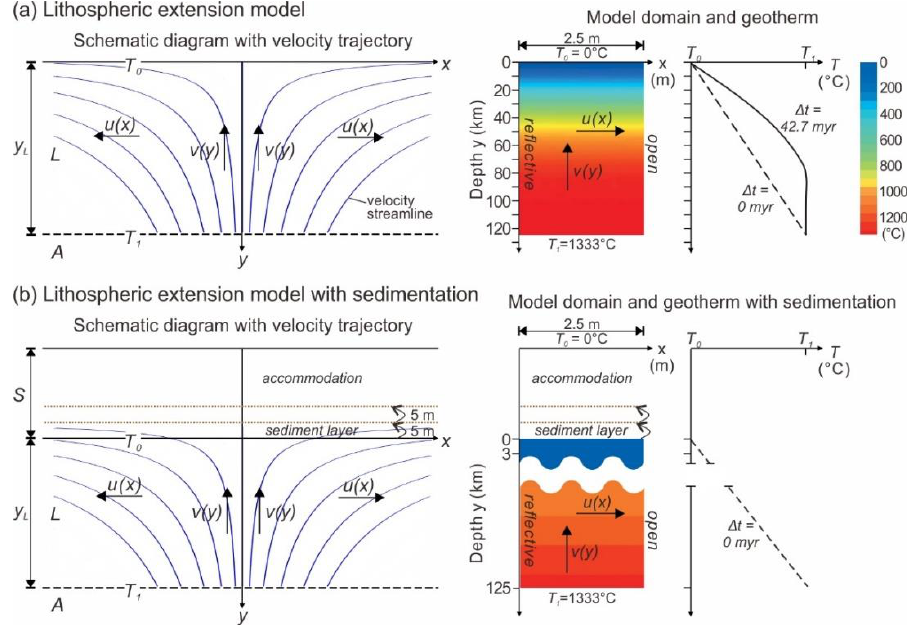
Figure 2. ( a ) Numerical lithospheric extension model (modified from [41]). A schematic diagram showing boundary conditions and velocity streamlines. Model domain and geothermal gradient of β = 2 and extension duration ∆ t = 42.7 myr. Steady-state temperature profile ( ∆ t = 0 myr) is shown (dashed line). ( b ) Numerical lithospheric extension model with successive stacking of 5 m thick sediment layers. A schematic diagram showing boundary condition, velocity streamlines, predefined accommodation, and sediment layers (dotted brown line). Model domain and geothermal gradient are shown with the steady-state temperature profile. L : lithosphere, A : asthenospheric mantle, S : predefined accommodation, T 0 : temperature of lithosphere top, T 1 : temperature of asthenospheric mantle, u ( x ) : horizontal velocity, v ( y ) : vertical velocity.